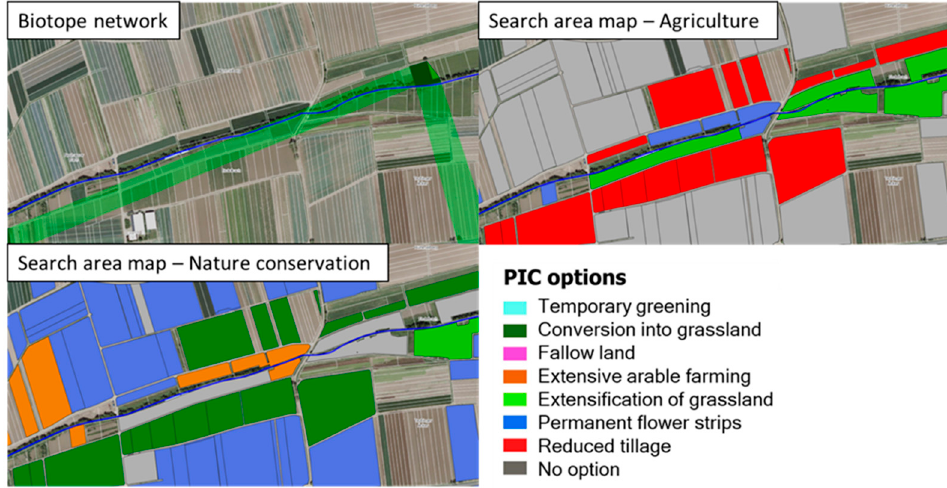
Figure 8. Application of the regional map using the example of an agricultural landscape segment in Filderstadt based on the IACS data and LUBW [.63]